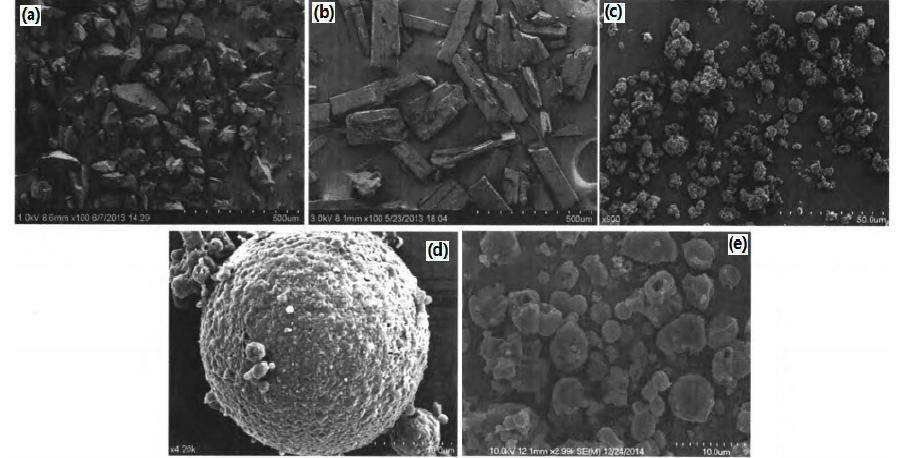
Figure 7. SEM photographs of explosive samples. ( a ) Raw CL-20 (×100); ( b ) Raw TNT (×100); ( c ) CL- 20/TNT cocrystal (×900); ( d ) CL-20/TNT cocrystal (×4200); ( e ) Spry drying CL-20 [20] , with permission from Han Neng Cai Liao, 2015.